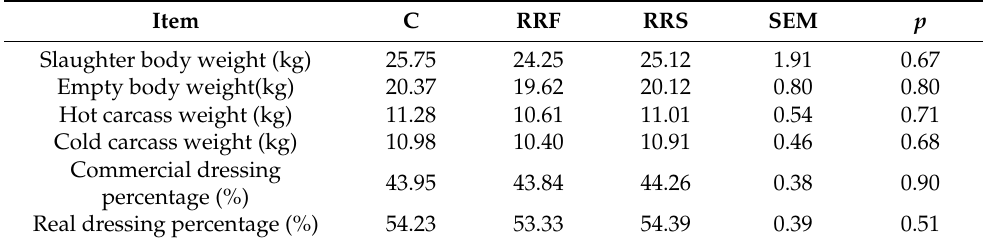
Table 2. Body weight, empty body weight, carcass weight and dressing percentage in Barbarine lambs fed RR-based concentrate.